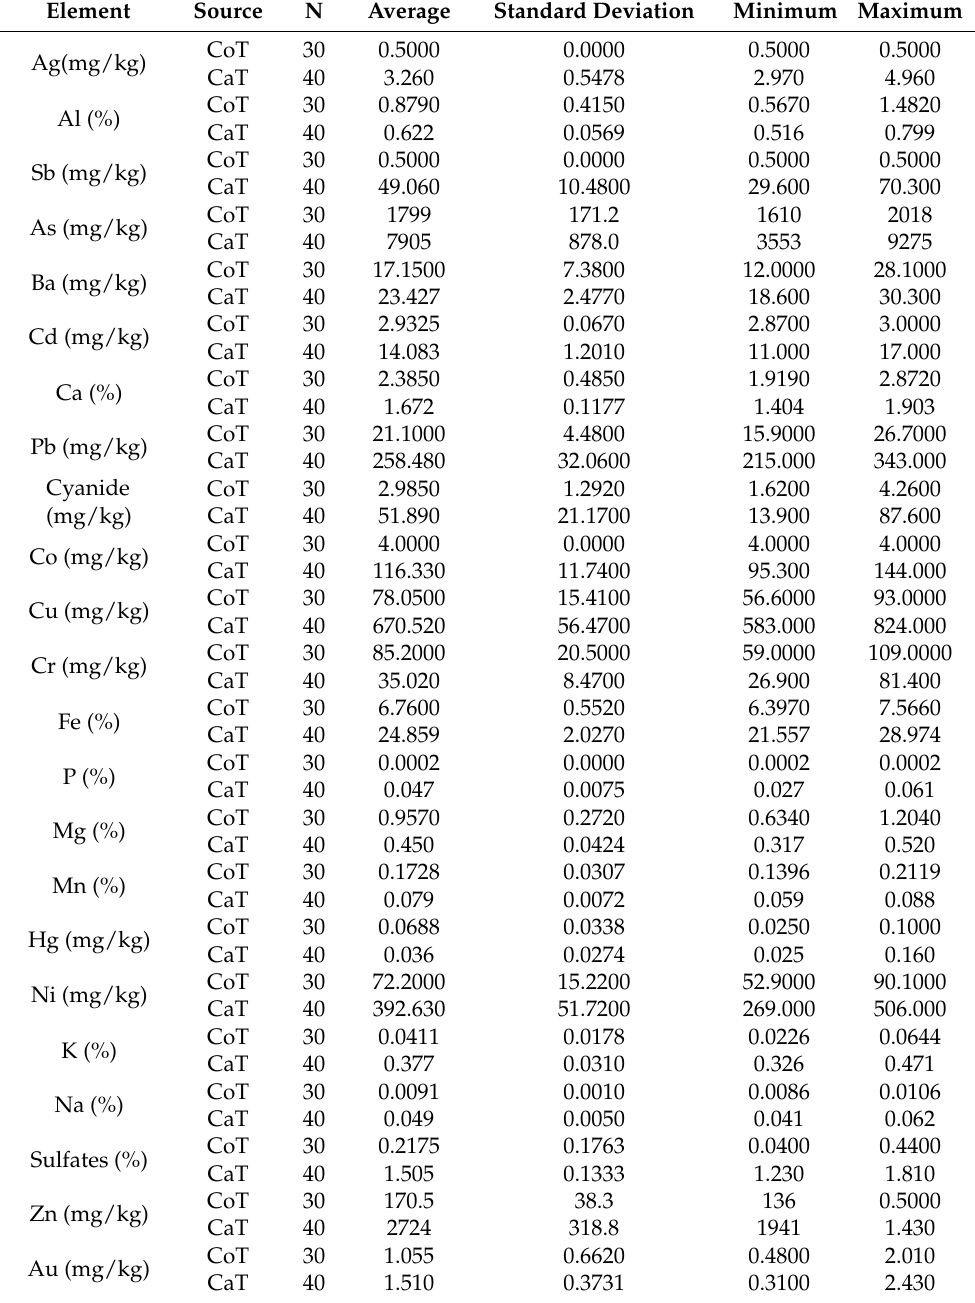
Table 1. Statistical summary of the major and trace elements. CoT—old circuit; CaT—ongoing circuit; N—number of